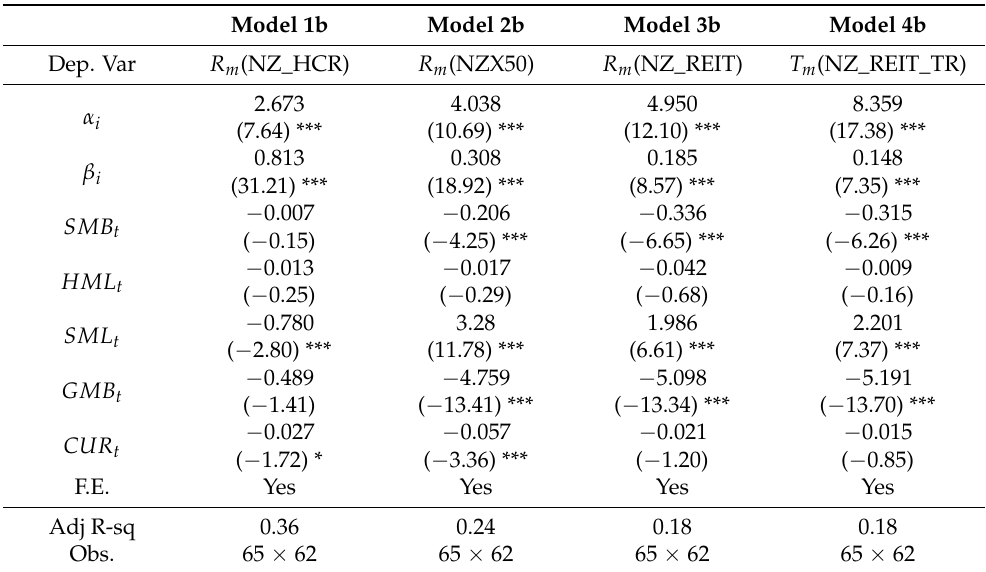
Table 5. Results of the Five-factor Fama-French